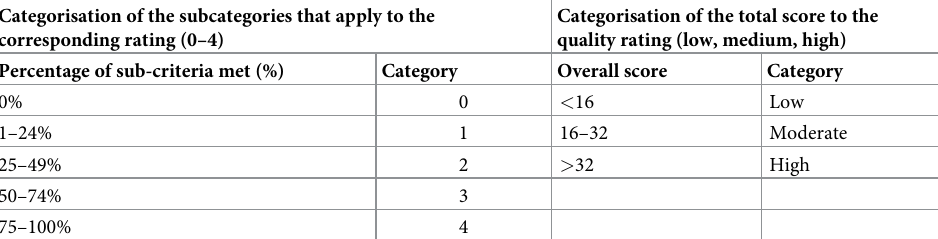
Table 3. Adapted rating of the quality of reviews , based on AMSTAR-2 [43]. Categorisation of the subcategories that apply to the corresponding rating (0–4)